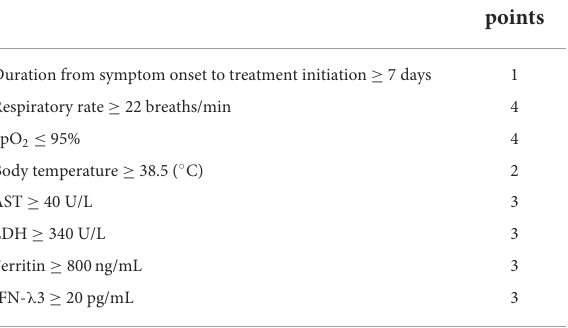
Components Number